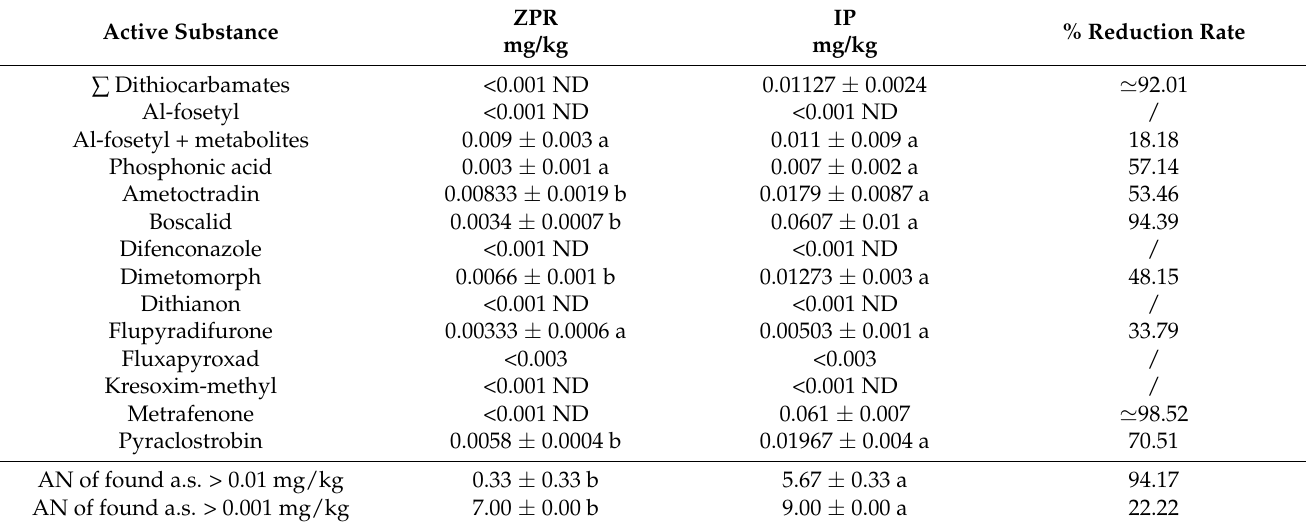
Table 9. Average concentration (mean ± SE) of pesticide residues in Pinot Gris grapes. A result of <0.001 ND means that a.s. was not detected at a level higher than 0.001 mg kg − 1 . /—concentration reduction rate and significance of difference between IP (integrated) and ZPR (0-pesticide residue) means cannot be calculated. Pesticide concentration reduction rate (%) = 100 − ((ZPR/IP) × 100) (see explanation in Section 2.4).